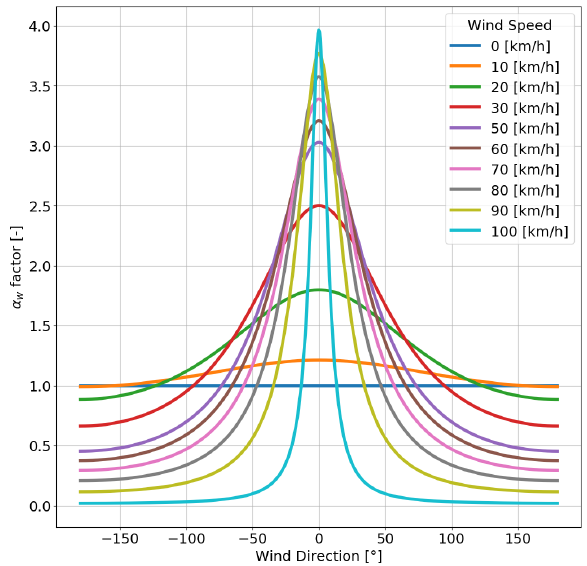
Figure 7. Wind influencing factor α w